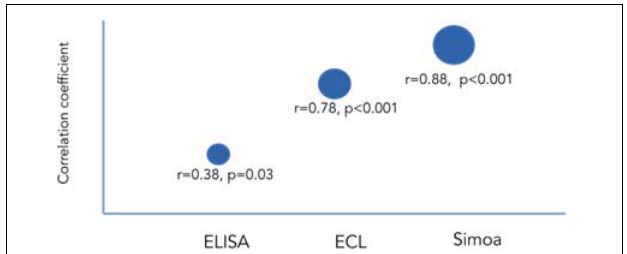
FIGURE 1 | Correlation between cNfL and bNfL across different technologies as reported by Kuhle et al. (2016a). Correlation coefficients between cNfl and bNfL levels measured with ELISA, ECL, and Simoa.